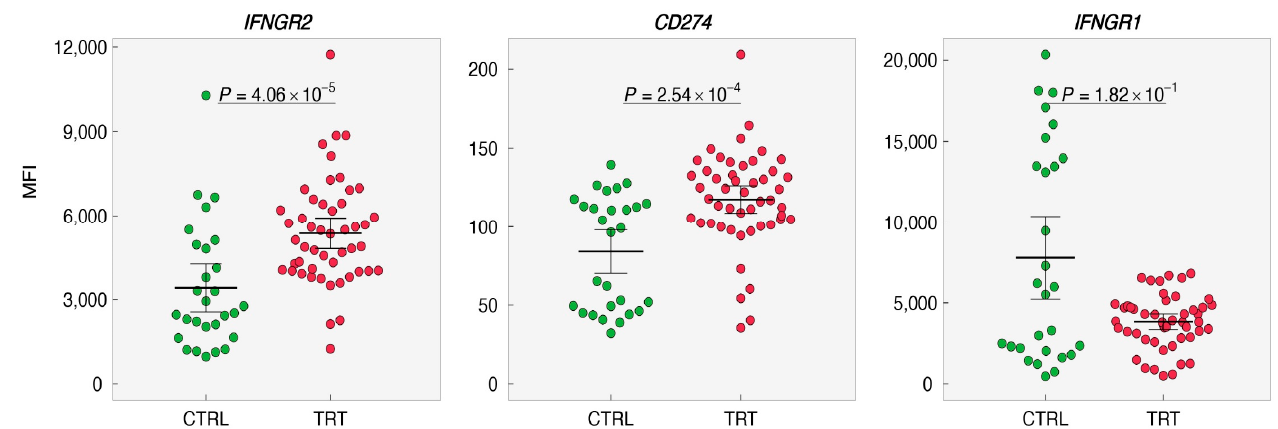
Figure 6. Impact of IL-3 priming on the expression of IFNGRs and PD-L1 on human basophils. The expression levels of IFNGR1 , IFNGR2 , and CD274 (PD-L1) in control (CTRL, 0–24 h) or treated basophils (TRT,24–48 h) were retrieved from (http://www.basophil.net and http://162.129.217.250/basophilMicroarrays; accessed on 5 February 2022) [15]. Statistical analyses were carried out using the R program (www.r-project.org (accessed on 5 February 2022)). Measurement data between two groups were performed using a nonparametric Mann–Whitney test. p < 0.05 was considered significant. MFI—median fluorescence intensity.